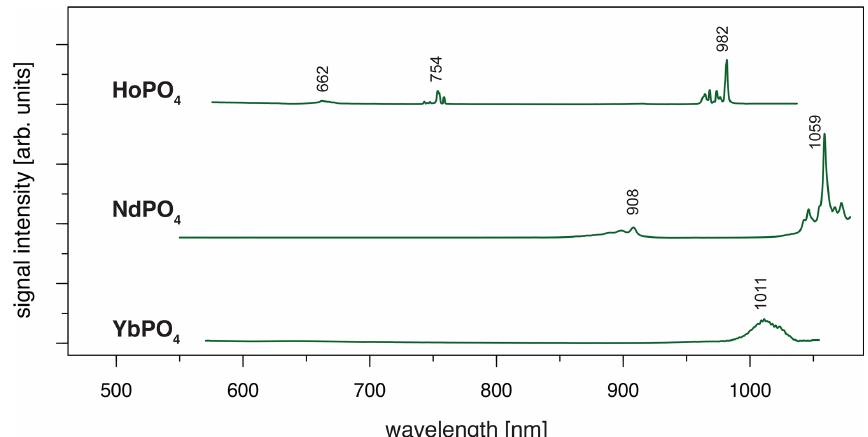
Figure 7. LiF reference spectra obtained with 532nm laser excitation depict the diagnostic emission lines for the REE phosphates HoPO 4 , NdPO 4 and YbPO 4 (given values represent wavelength of most intense emission in nanometres for each transition; cf. Table